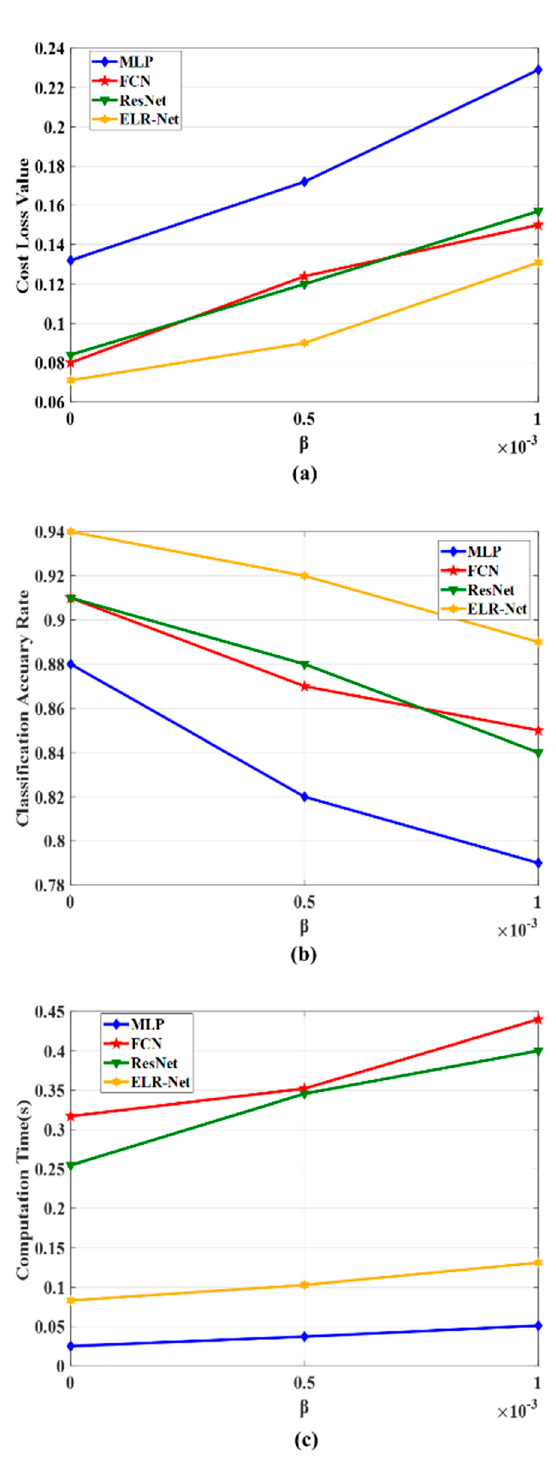
Figure 10. Performance comparison of MLP, FCN, ResNet, and ELR-Net, when β = 0.0001 β = 0.0005 and β =0.001.